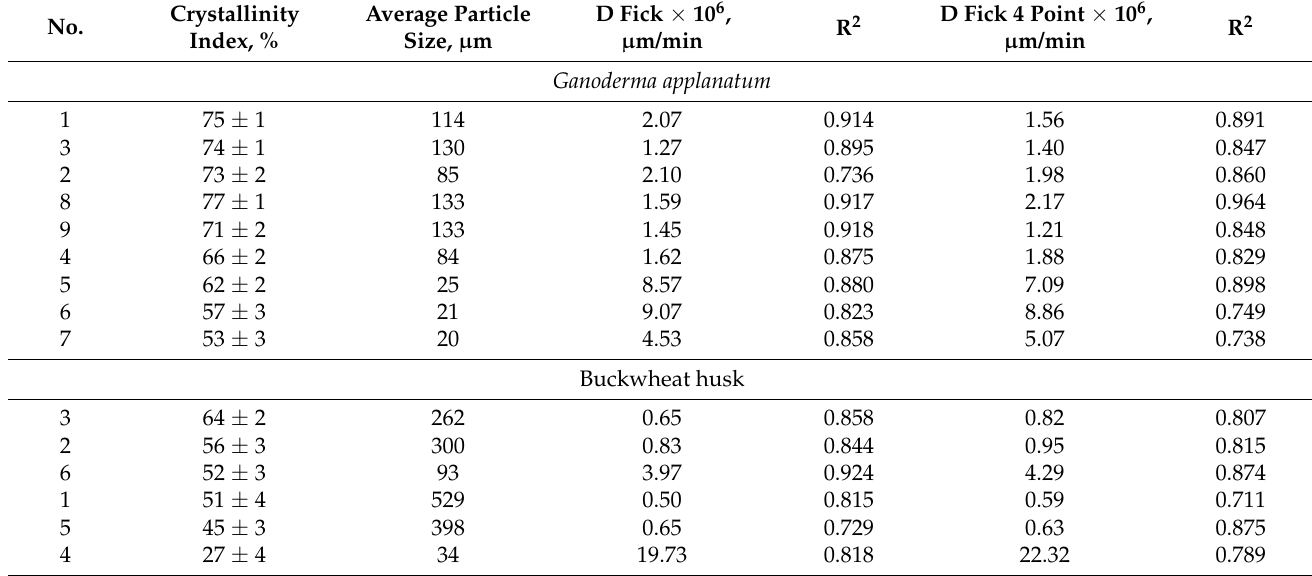
Table 2. The diffusion constant according to the first order equation as a function of particle size and crystallinity index. No.